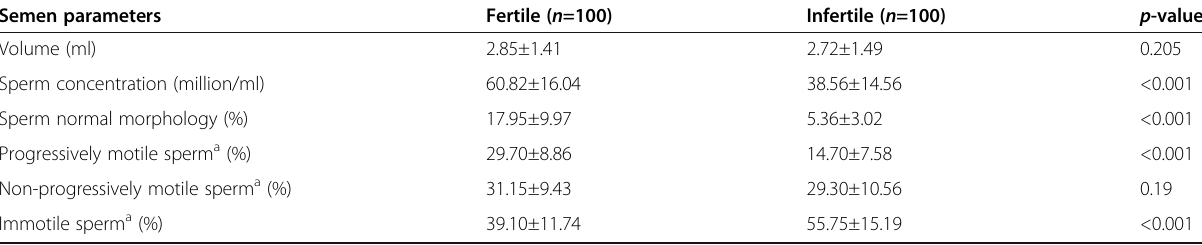
Table 2 Semen profile of infertile and fertile males Semen